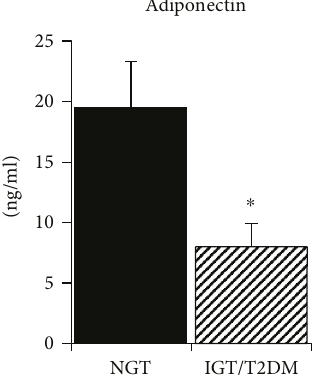
Figure 2: Adiponectin levels in NGT and IGT/T2DM groups. Values are mean ± SEM . Signi fi cantly di ff erent between groups, ∗ P < 0 01